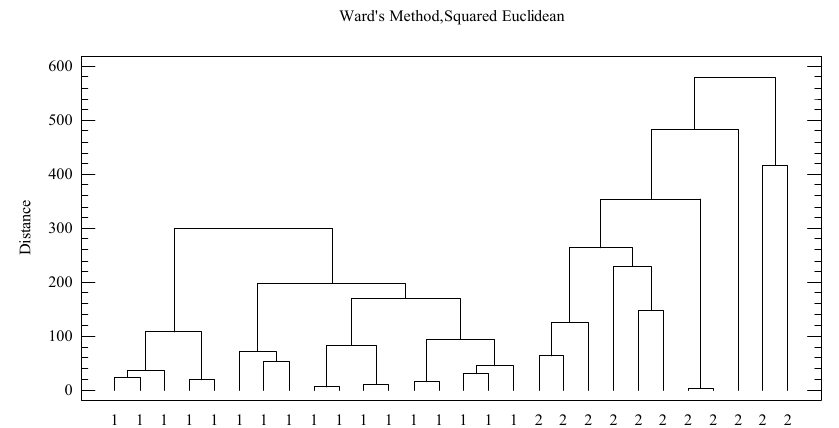
Figure 2. Cluster analysis of the honey samples. 1: oak honeydew. 2: evergreen oak